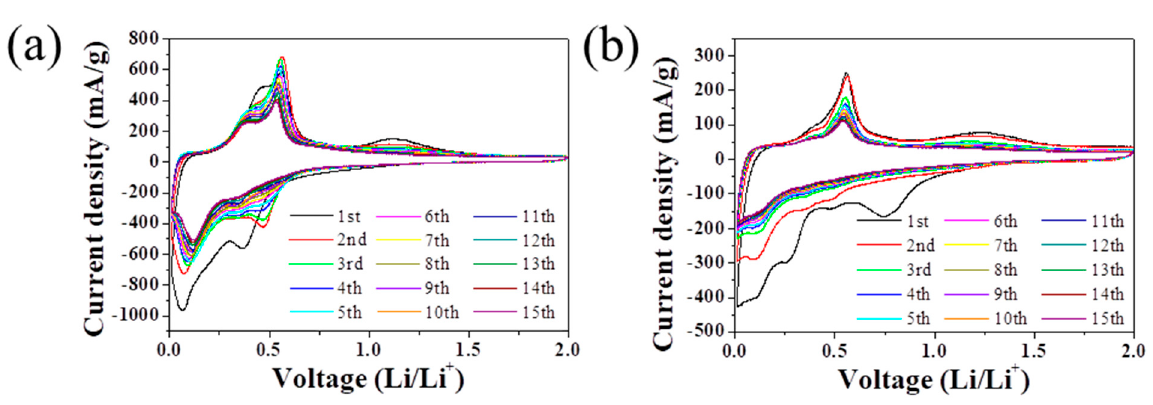
Figure 7. CV curves of ( a ) Ge/GeO 2 NPs and ( b ) Ge/RuO 2 nanocomposite at a scan rate of 0.1 mV s − 1 .